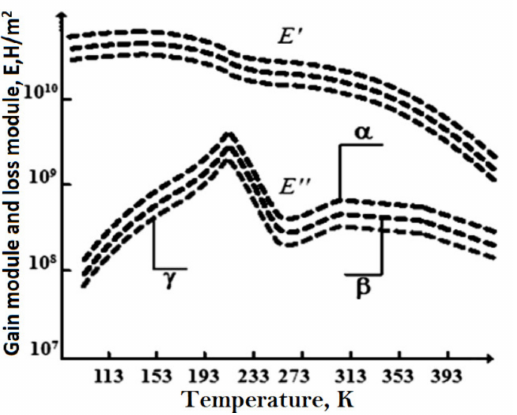
Figure 1. Temperature dependences of the dynamic mechanical characteristics of PVDF: storage modulus (E’) and loss modulus (E”) of isoth ermally crystallized and directionally crystallized samples of the α -phase of PVDF: 1—parallel; 2—perpendicular; 3—isothermally crystallized sample (spectra are numbered from top to bottom)